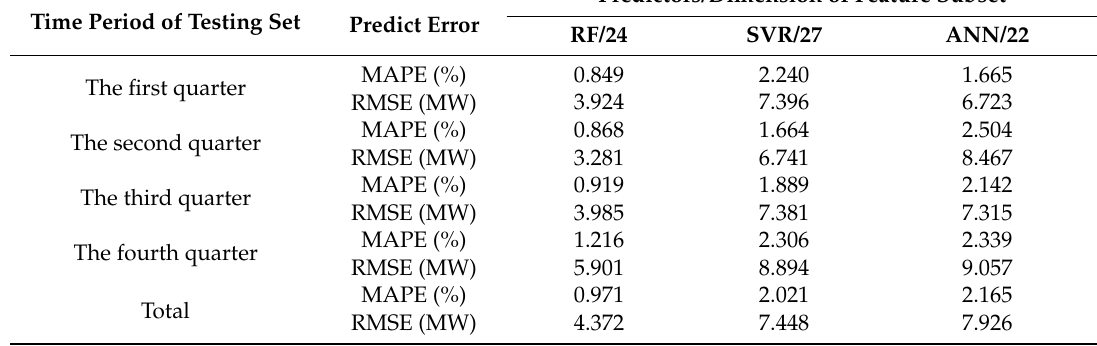
Table 10. Mean absolute percentage error (MAPE) and root mean square error (RMSE) of random forest (RF), support vector regression (SVR), and artificial neural network (ANN) on the different testing sets of 1-h-ahead prediction.